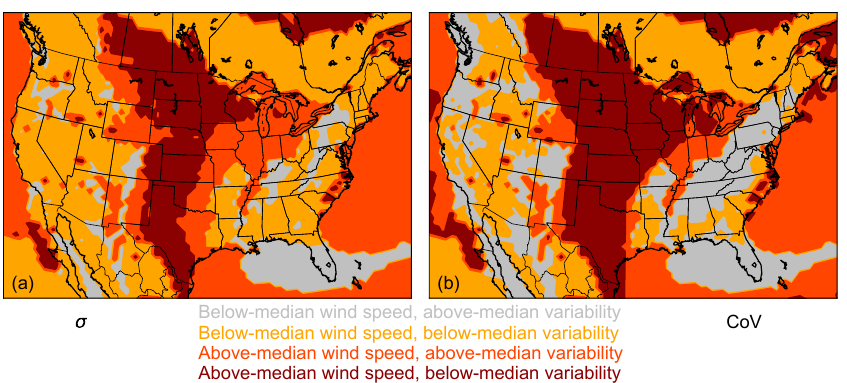
Figure A4. As in Fig. 10d, but the spread metrics are (a) σ and (b) CoV, calculated using monthly mean wind speeds of 37